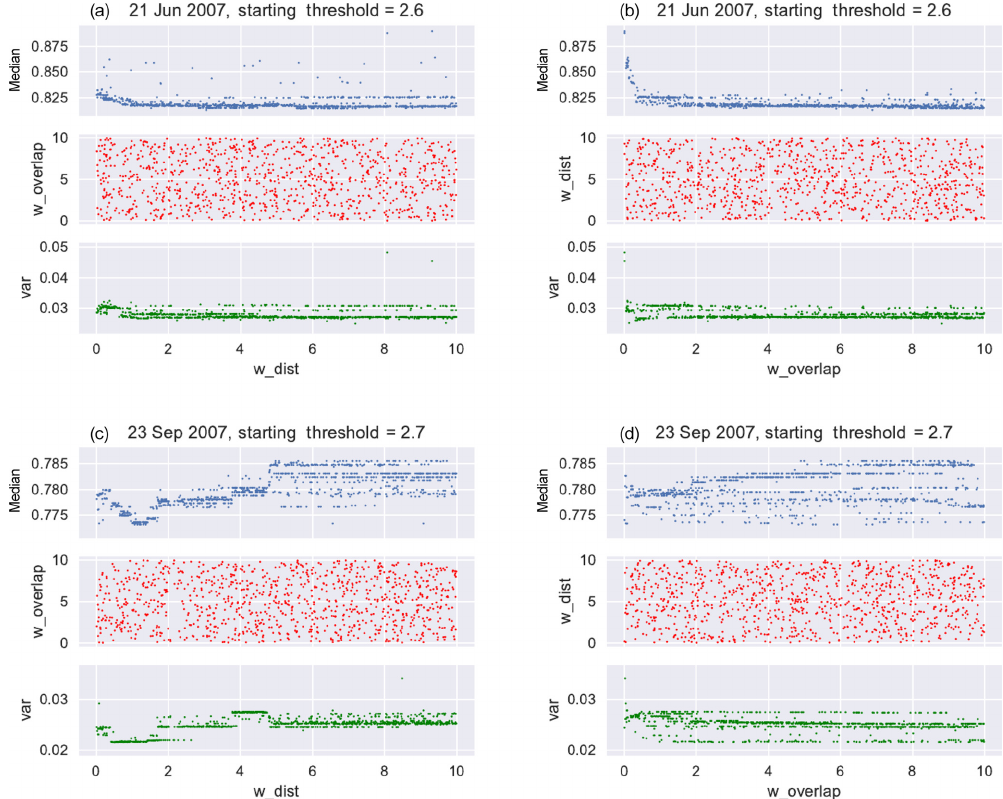
Figure A1. Scatter plots do not indicate a nonlinear relationship between weights and sample statistics. w o and w d are indicated as w _dist and w _overlap on the x